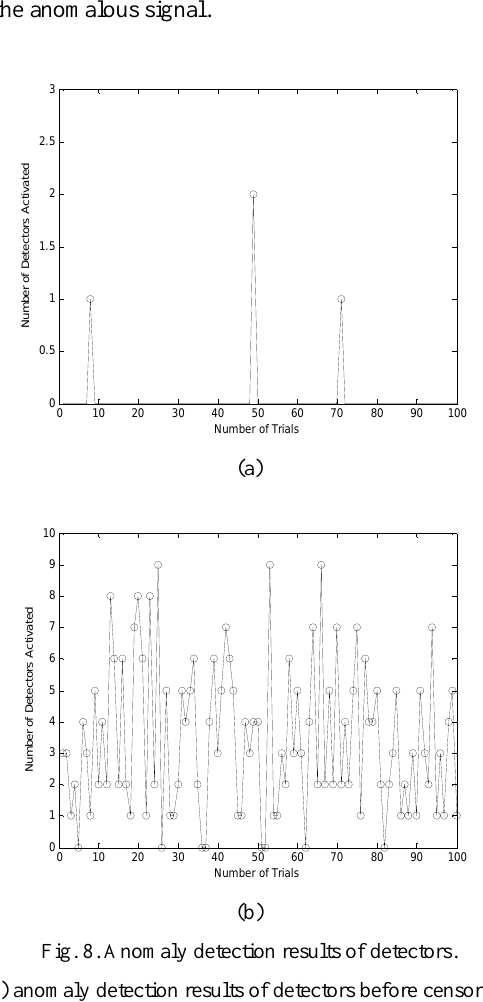
Fig. 7. of normal and abnormal signals. V